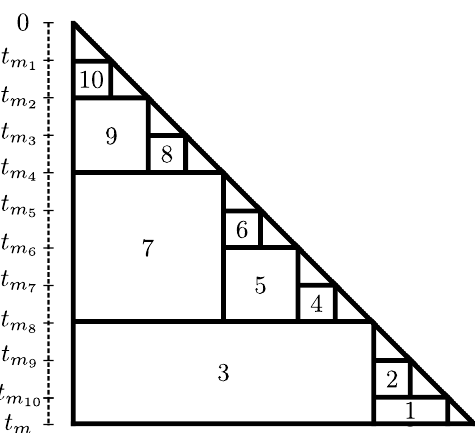
Figure 3: The portion of compressed representation depicted in Fig. 2 which has been constructed by the outer time step t = t for the retarded Green’s function and m self energy. The block numbering indicates the order in which blocks are applied when computing the history sums I R ,1 n , m